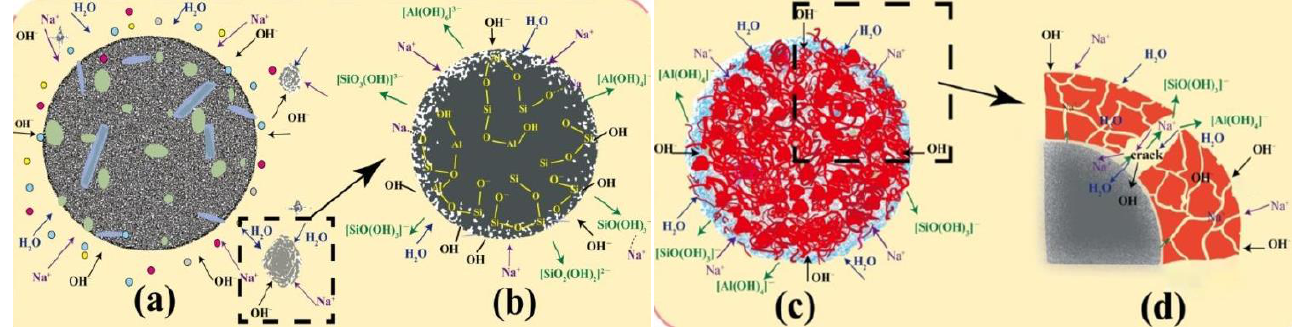
Figure 16. Reaction process and hydration product formation mechanism of low-calcium fly ash stimulated by alkali [37]: ( a ) dissolution stage; ( b ) depolymerization stage; ( c ) polycondensation and polymer gel stage; ( d ) diffusion stage.